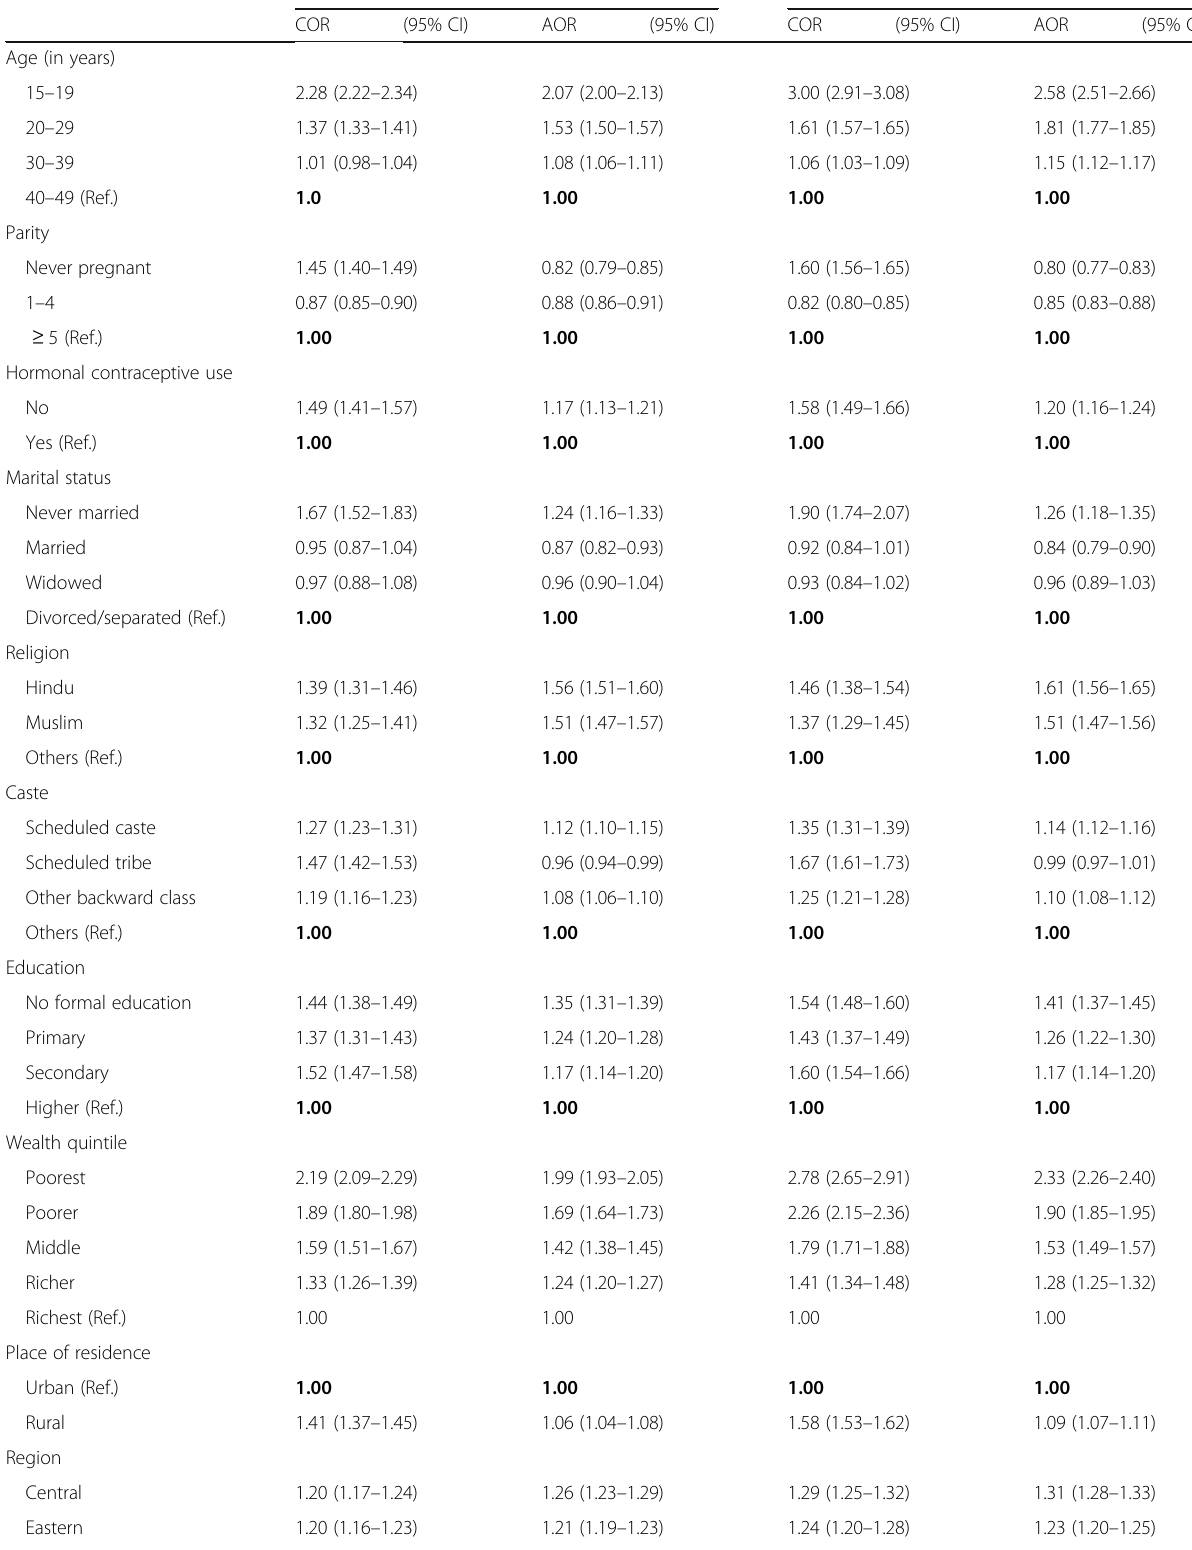
Table 3 Determinants of underweight among women of reproductive age in India 1,2